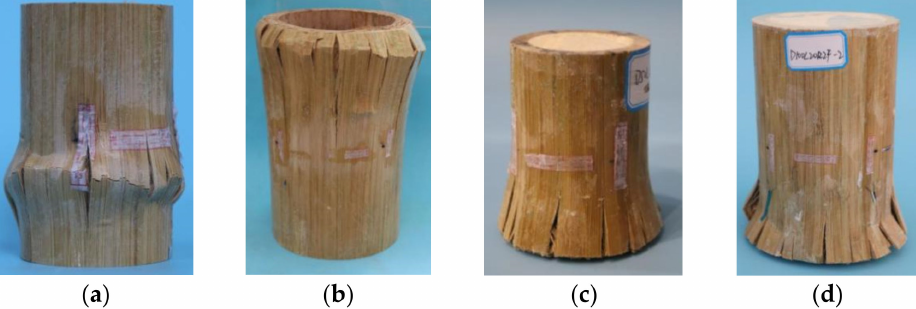
Figure 4. Failure modes of polyurethane foam-filled bamboo composite tubes. ( a ) D50 buckling; ( b ) D100 buckling; ( c ) D50F bearing; ( d ) D100F